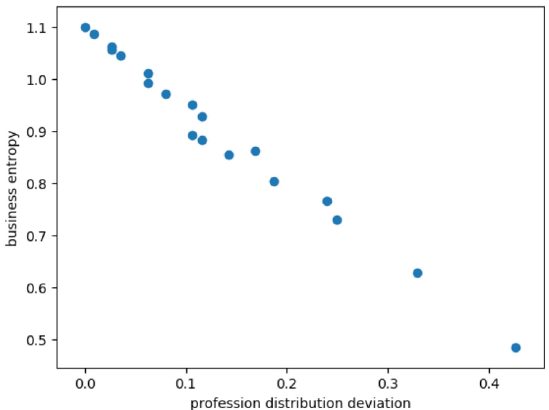
distribution deviation and business entropy by taking the expected distribution as uniform